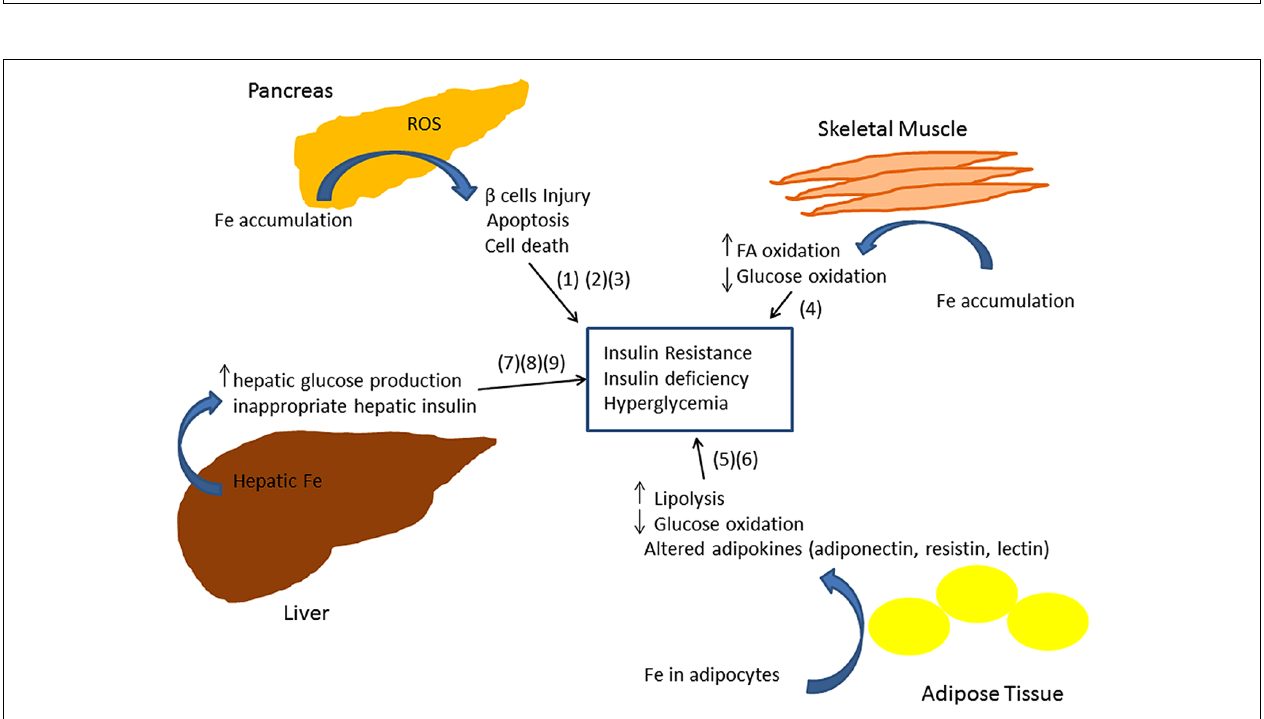
FIGURE 2 | Model showing multiple mechanisms through which iron can lead to insulin resistance and insufficiency (Merkel etal., 1988;Tiedge etal., 1997; Mendler etal., 1999; Ferrannini, 2000; Cooksey etal., 2004; Green etal., 2006; Huang etal., 2011).